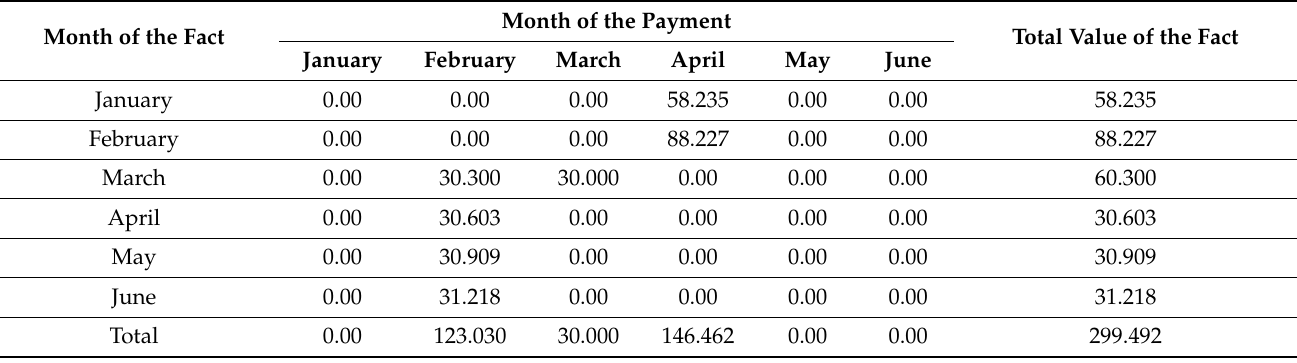
Table 6. Discounted (accrued) value of payments involved in determining value of the fact (FPLS), thousand $.